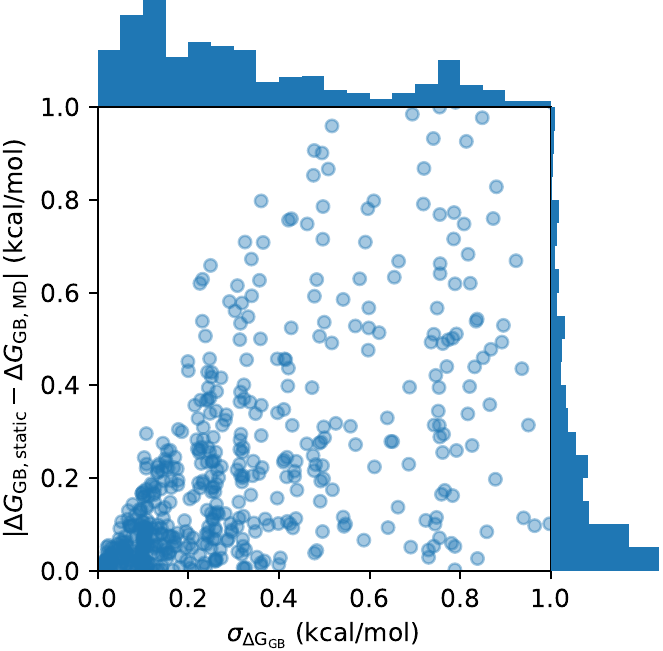
Figure 1. Categorizing rigid and flexible molecules from MD simulations. The standard deviation of the combined GB and surface area from MD simulations is given on the x axis. The difference between E GB calculated from just the first frame (static) and over the entire MD trajectory is given on the y axis. Histograms for both quantities are given on their respective axes. For clarity, the full range of the data is not shown, which has maximum values of σ ∆ G − ∆ G | ∆ G | = GB,static GB,MD